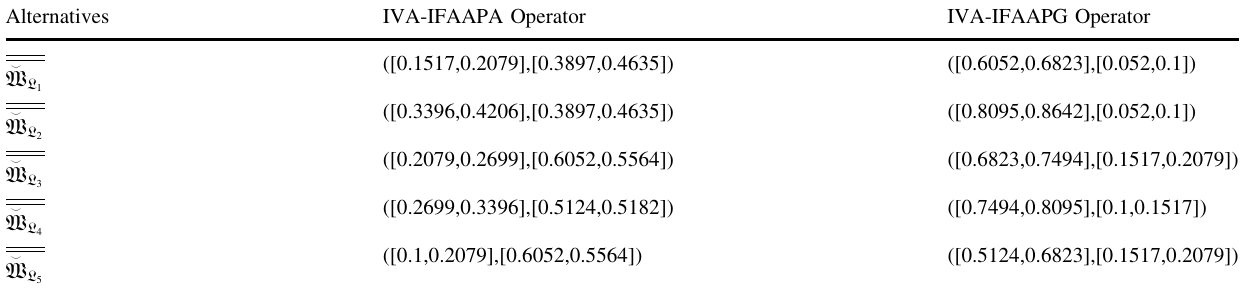
Table 6 The aggregated results for each alternative